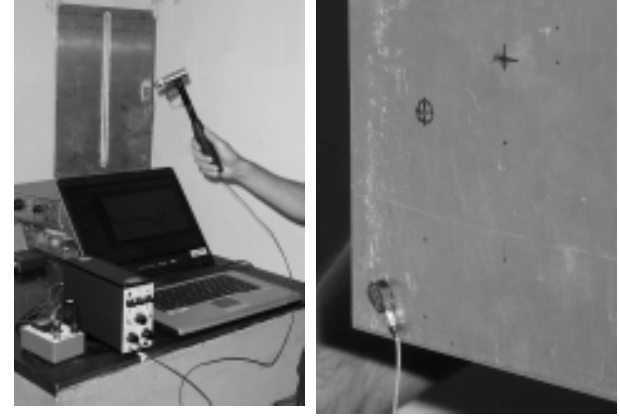
Fig. 5. Experimental setup for the dynamic